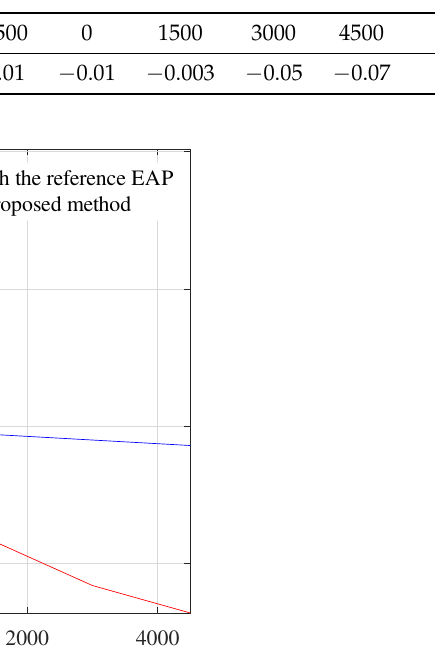
Table 3. Imaging results for targets at swath edge, calibrated by the proposed method.